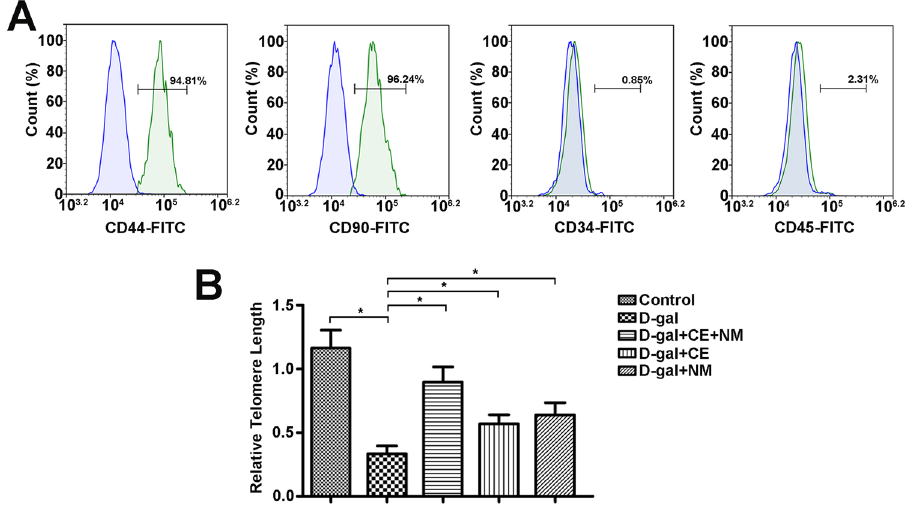
Figure 1. Identification of BMSCs and telomere lengths of BMSCs in aging rats. ( A ) BMSCs were stained with surface markers and examined by flow cytometry. These cells were positive for CD44 and CD90, and negative for CD34 and CD45. ( B ) Real-time PCR technique was used to measure the relative telomere length. The relative telomere length was calculated as the ratio of telomere repeats to a single-copy gene. CE and NM supplement inhibited telomere shortening in aging rat BMSCs. Data were the means ± SD of triplicate determinants ( * P <